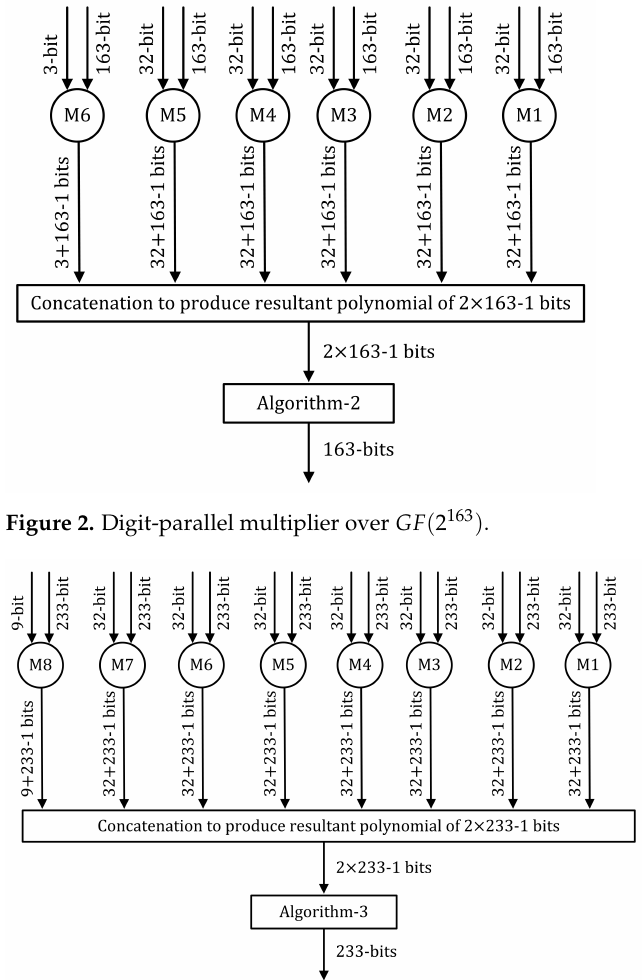
Figure 3. Digit-parallel multiplier over GF ( 2 233 ) .